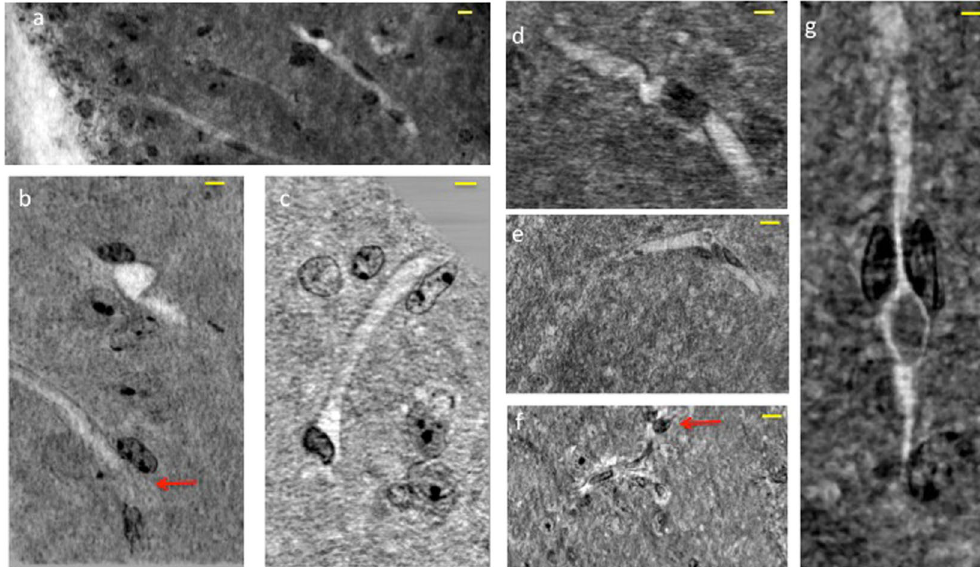
Figure 6. XPCT-mediated detection of capillary alterations in EAE. Details were selected in the EAE sample, in a volume of about 50 μ m in thickness. This thickness is suitable to appreciate the 3D volume of the single capillary and its surroundings, an impossible task for TEM, where sections not thicker than 120 nm have to be used. The white channels are the capillaries and the black contrast comes from the osmium, which highlights the cell membranes. Scale bars: 8 μ m. The pixel size of the nano-XPCT is 130 nm (spatial resolution ~260